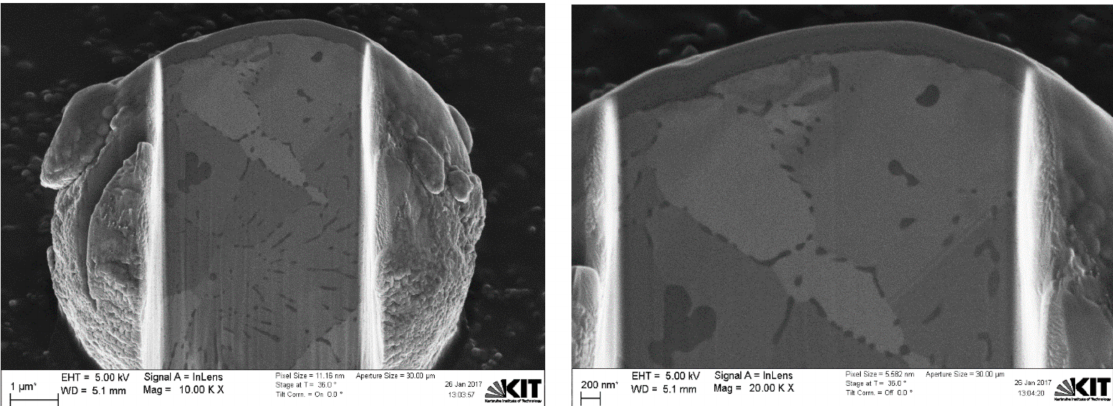
Figure 12. Dual FIB-SEM images with the InLens detector mode of a sectioned 10 µ m APS Cu particle.